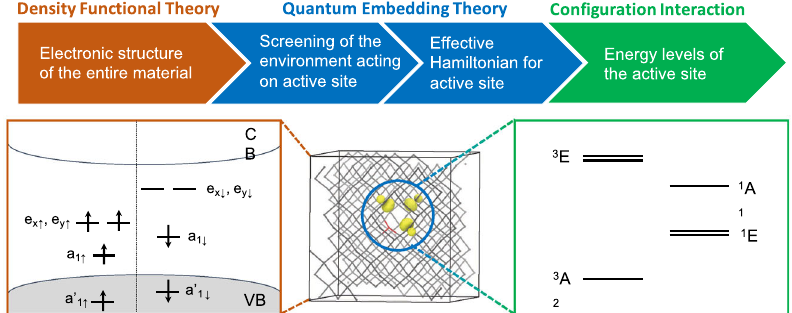
Fig. 4 Quantum embedding theory. In vivo coupling of the Qbox 14 and WEST 16 codes was used to build an embedding theory to study strongly correlated defects in semiconductors and insulators 116,117 . Single particle wavefunctions and eigenvalues obtained from DFT calculations are used to compute the screening of the environment on a chosen active region of the material (de fi ned, e.g., by the localized single particle states of a defect). The screening enters the de fi nition of a second quantized Hamiltonian that may be diagonalized using con fi guration interaction techniques to obtain many body states of the